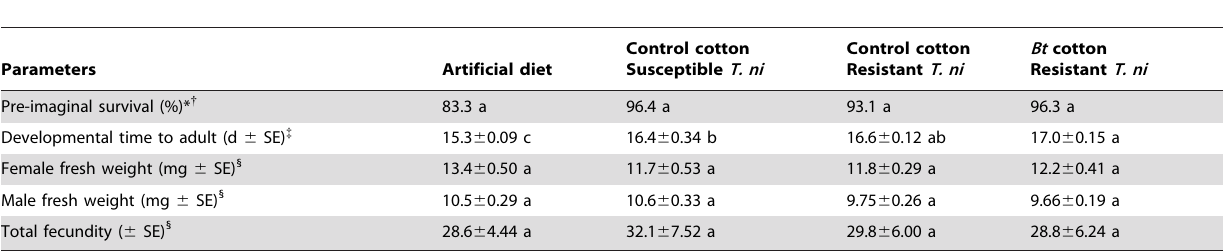
Table 1. Prey-mediated effects on life-table parameters of Coleomegilla maculata when fed Trichoplusia ni larvae that were reared on Cry1Ac/Cry2Ab-expressing Bt cotton leaves or the corresponding non-transformed cotton leaves.